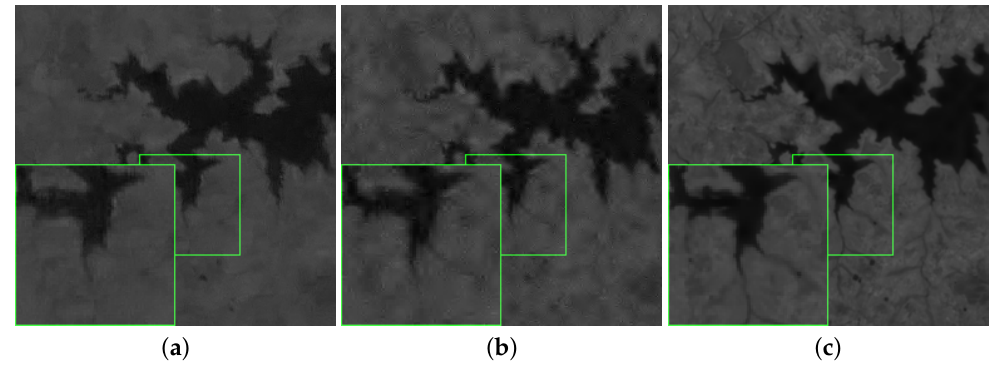
Figure 4. The reconstruction image of three methods. ( a ) L1-without reference information (WRI); ( b ) L1-RI; ( c )